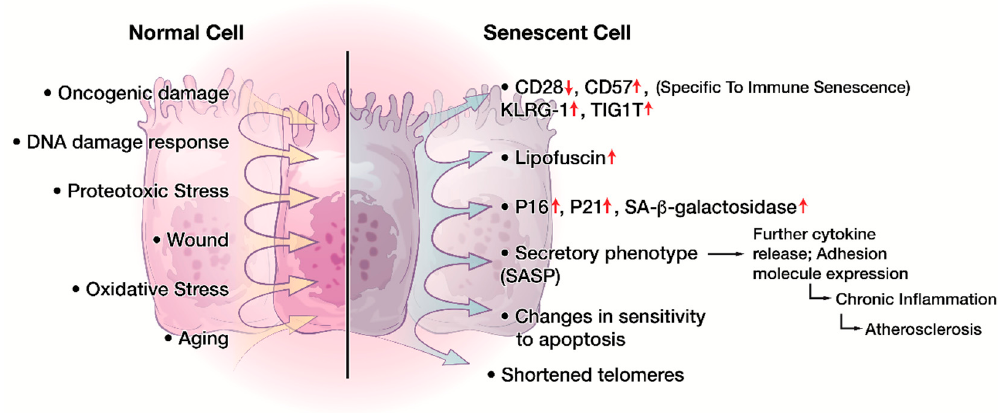
Figure 2. Phenotypical and molecular changes in cellular senescence. A variety of intracellular (DNA damage, oncogenes, etc.) and/or extracellular signals (oxidative stress, chronic inflammation, etc.) can induce cellular senescence. Senescent cells exhibit numerous characteristics including but not limited to cell cycle arrest, increased nuclear p16 and p21 expression, increased lysosomal SA ‐β‐ gal activity, shortened telomere, and increased lipofuscin. Senescent cells can also present as a specialized secretory phenotype termed senescence associated secretory phenotype (SASP). Of particular interest, senescent immune cells present with lowered expression of CD28 and CD27 but heightened expression of CD57, KLRG ‐ 1, TIGIT, and other NK ‐ cell associated surface receptors. Cellular senescence also occurs in the human immune system [18,95]. The effectiveness of the immune response declines with age particularly in the elderly population [96,97]. Immune deficiencies start to appear in DCs, NK cells, and monocytes/macrophages with aging, and it was